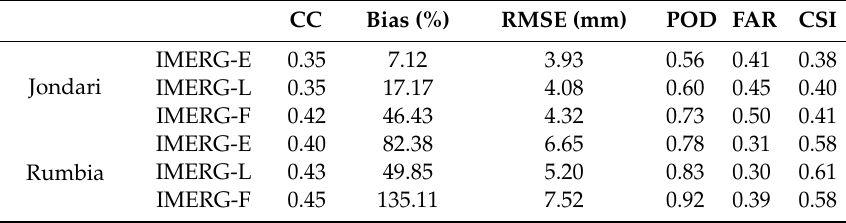
Figure 5. Box plots of the statistical indices of IMERG at an hourly scale versus the gauge observations over YRD. Table 5. Statistical indices of mean hourly precipitation from IMERG over